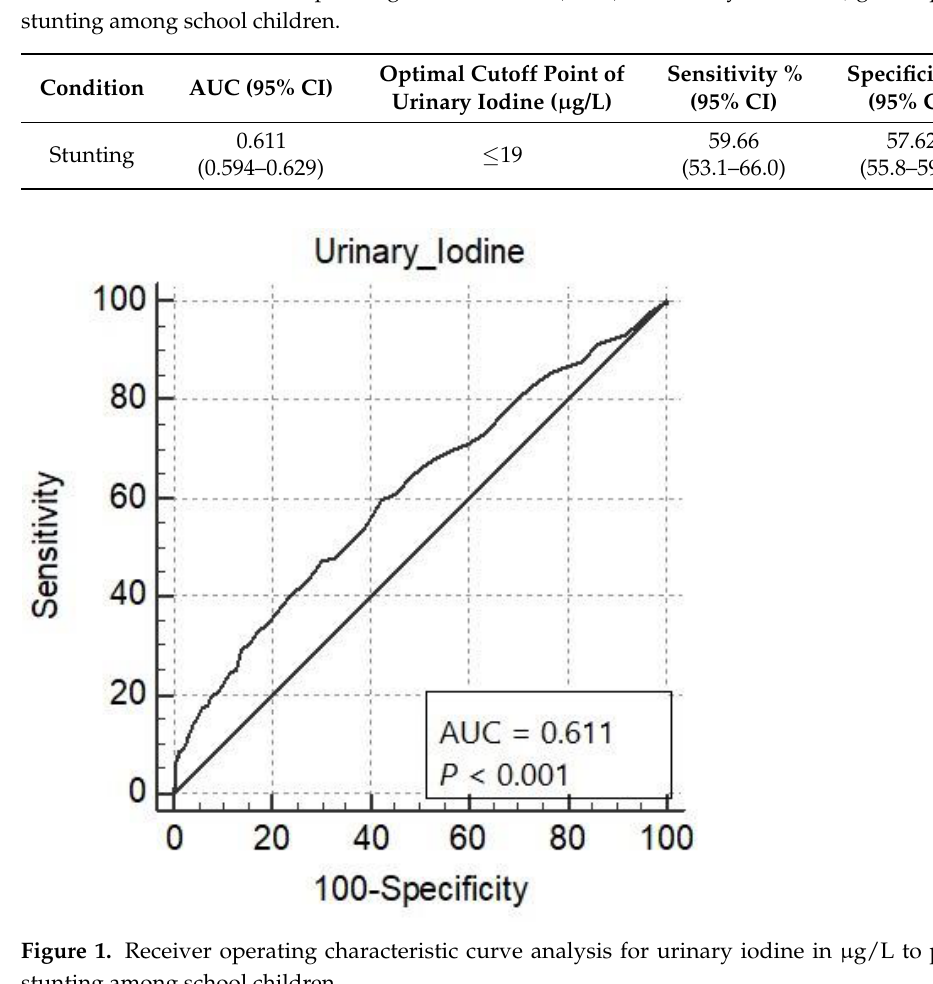
Table 2. Univariate and multivariable analysis for factors associated with stunting among school children ( n = 3046).